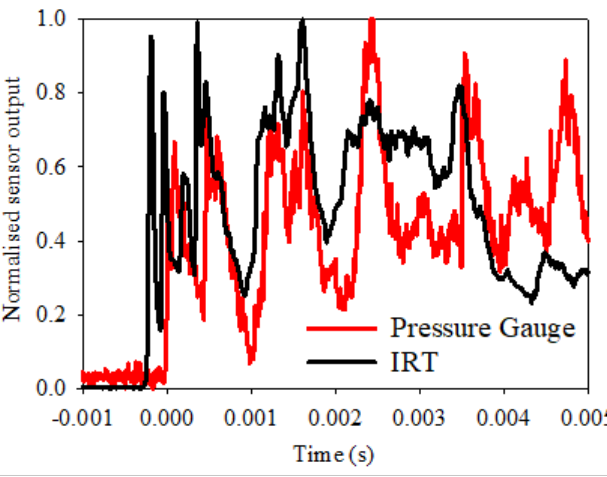
Figure 8. Comparison of the normalised sensor outputs of the confined blast for the first 5 ms of the fireball with both sensors connected to the same data logger.